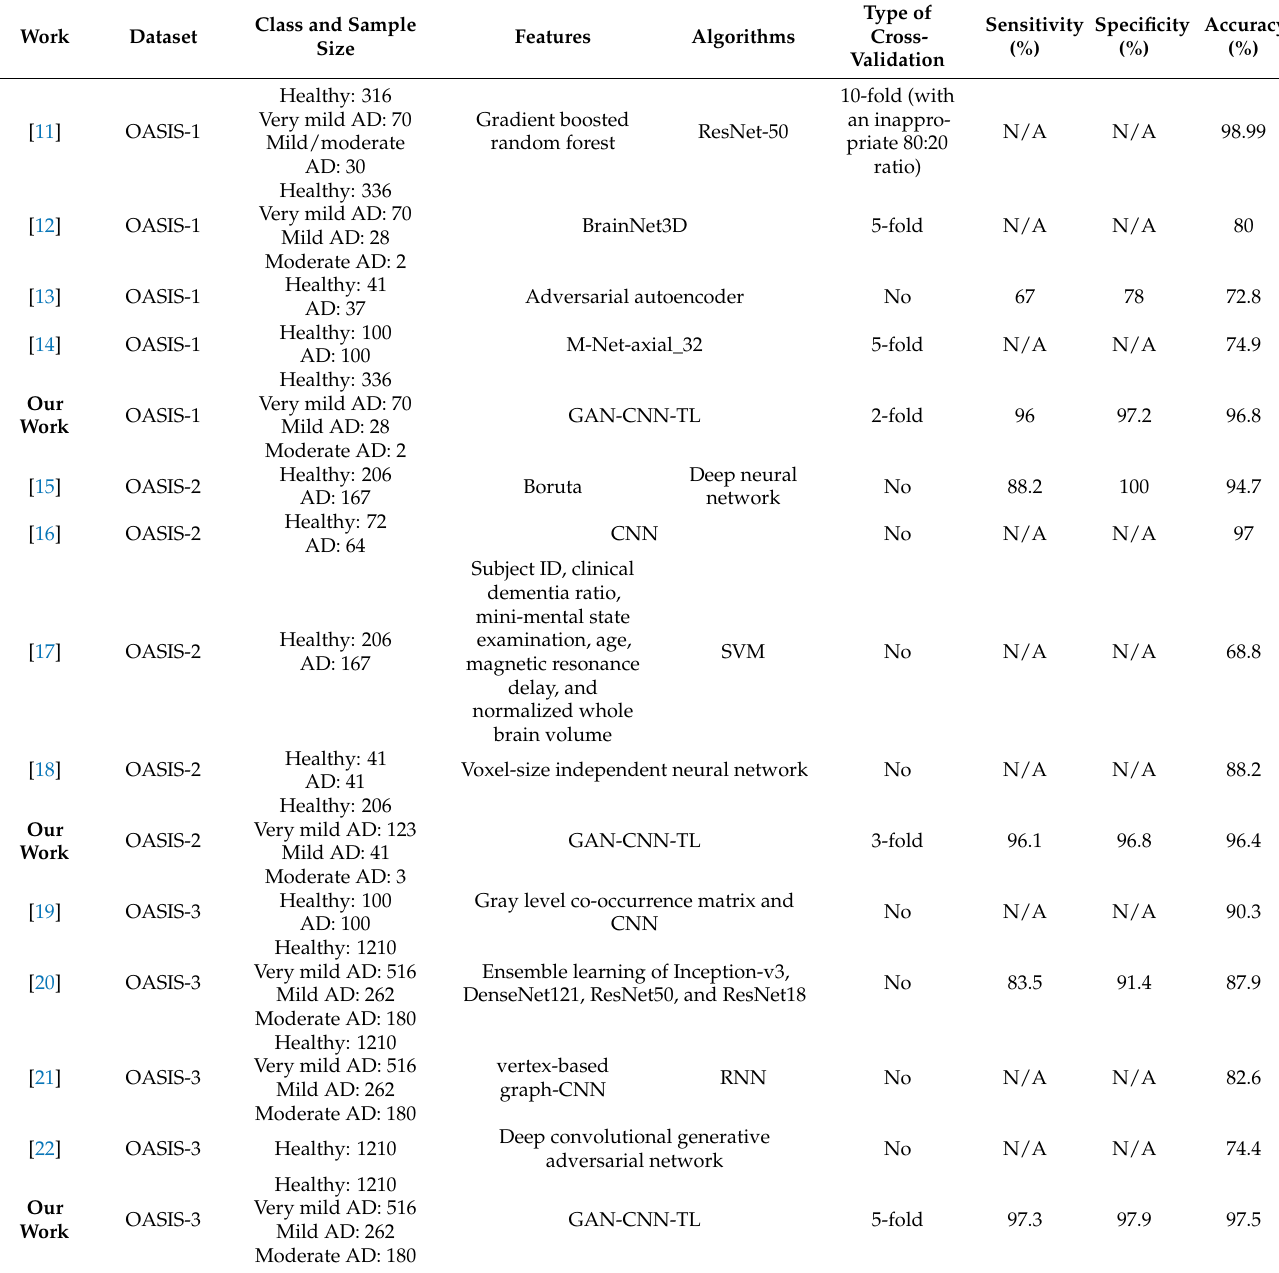
Table 6. Performance comparison between our work and existing